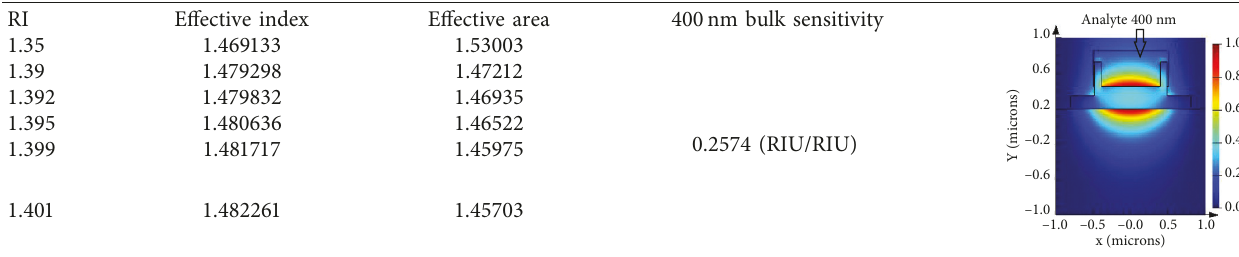
Figure 4: Transmission spectrum of normal cells with refractive index 1.35 vs Breast Cancer (MCF-7) cells with refractive index 1.401 of rib waveguide with integrated analyte thickness of 400nm, 250nm, 150nm, and 90nm. Table 3: Analysis of bulk sensitivity of the rib-slot waveguide with 400nm analyte thickness.